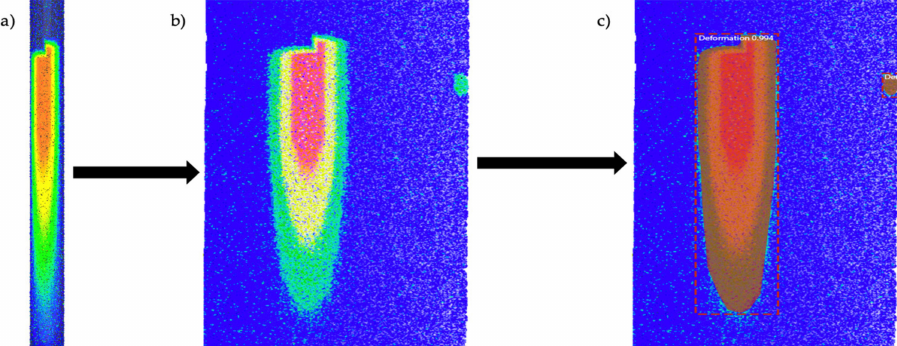
Figure 19. Point-to-point distance. ( a ) Point-to- point distance, ( b ) projected to plane, ( c ) segmented by Mask